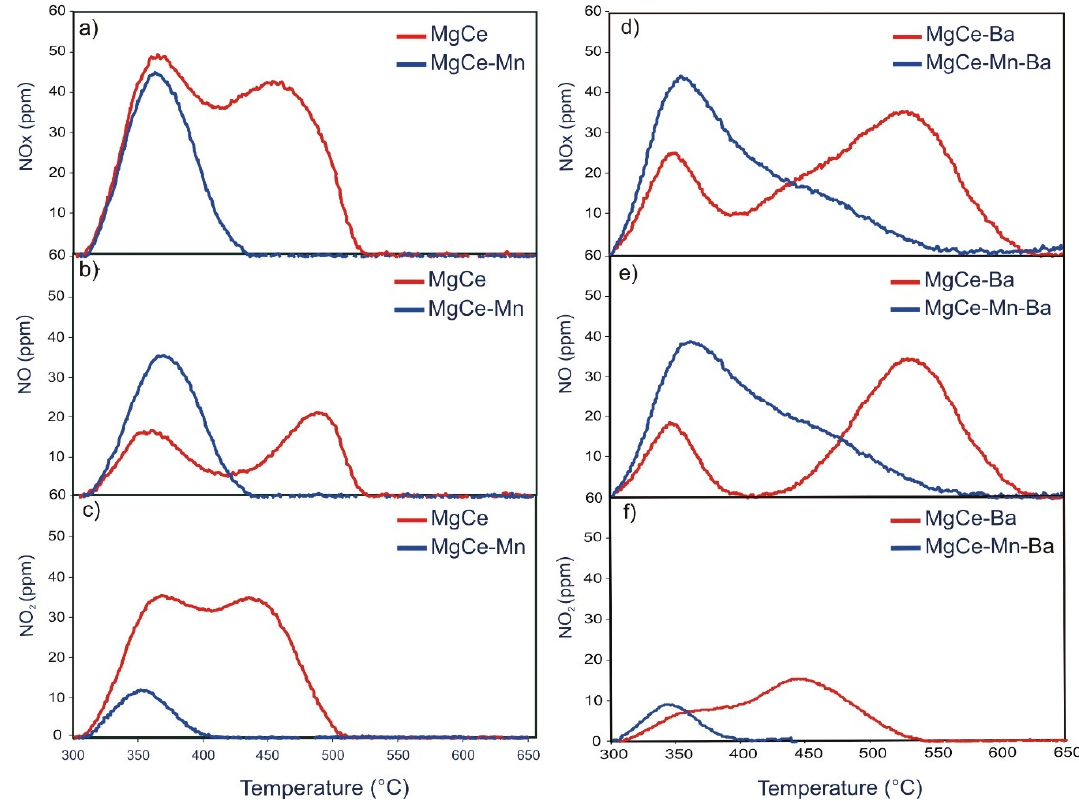
Figure 4. Temperature programmed desorption (TPD) profiles (dual-bed configuration) of MgCe and MgCe-Mn ( a ) NO x , ( b ) NO ( c ) NO 2 and MgCe-Ba and MgCe-Mn-Ba ( d ) NO x , ( e ) NO ( f ) NO 2 .